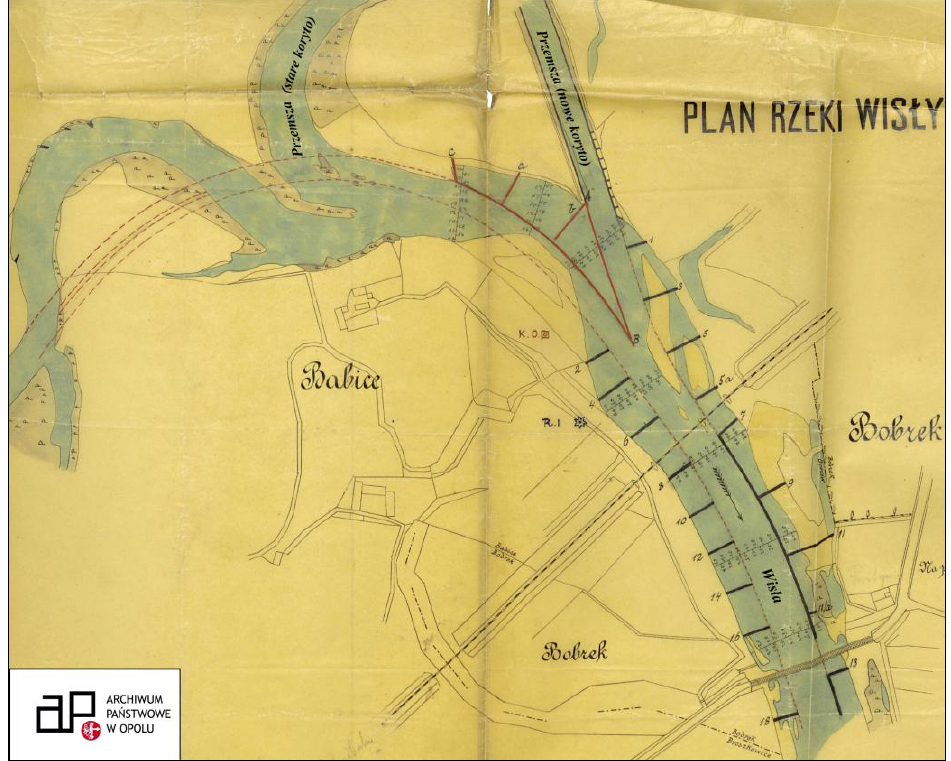
Fig. 12. River engineering work at the location where the River Przemsza enters the River Vistula in 1906 (after: Regulierung der Przemsza, original scale: 1:5,000, State Archives in